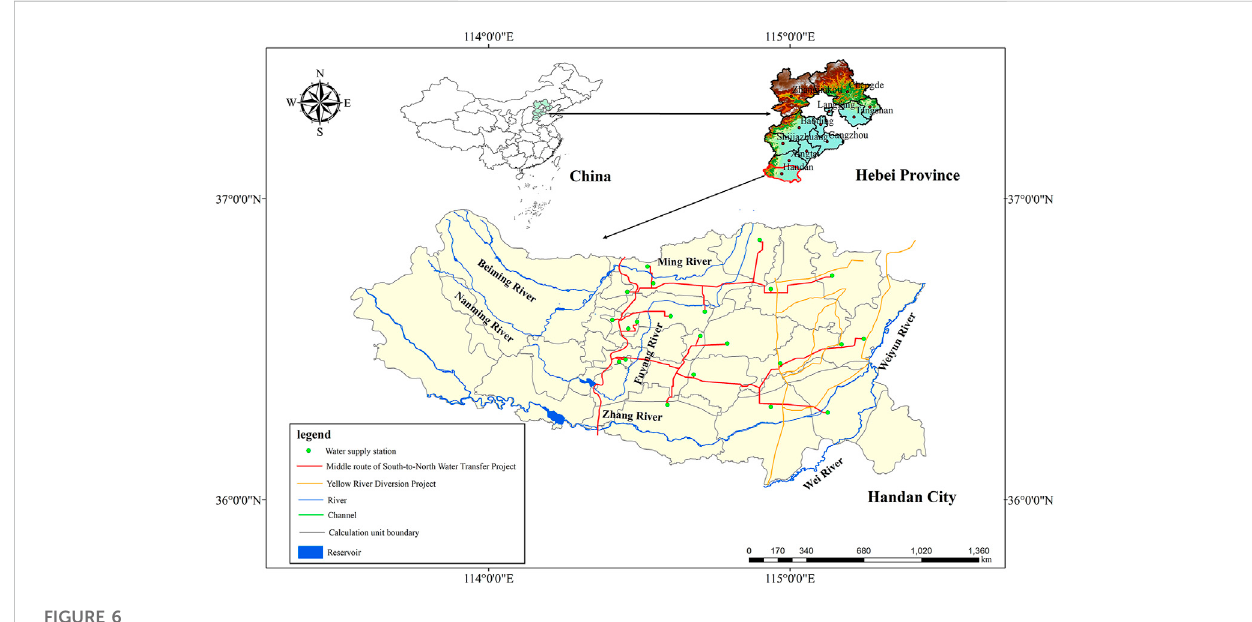
FIGURE 6 Overview of the study